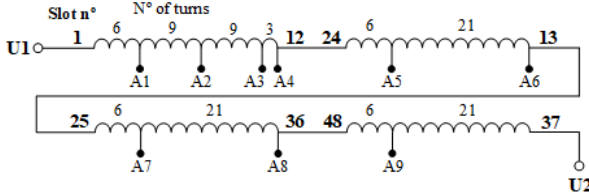
Figure 9. Phase winding schematic.